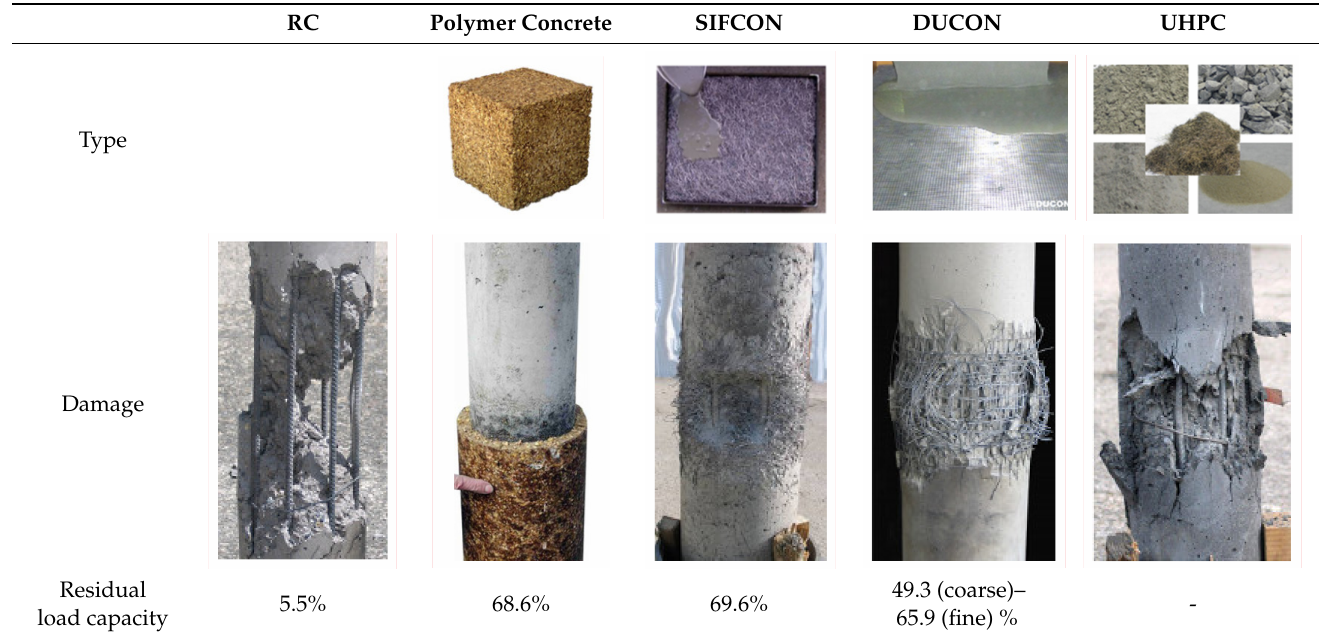
Table 3. Damaged columns after contact detonation and the residual load capacities [44].